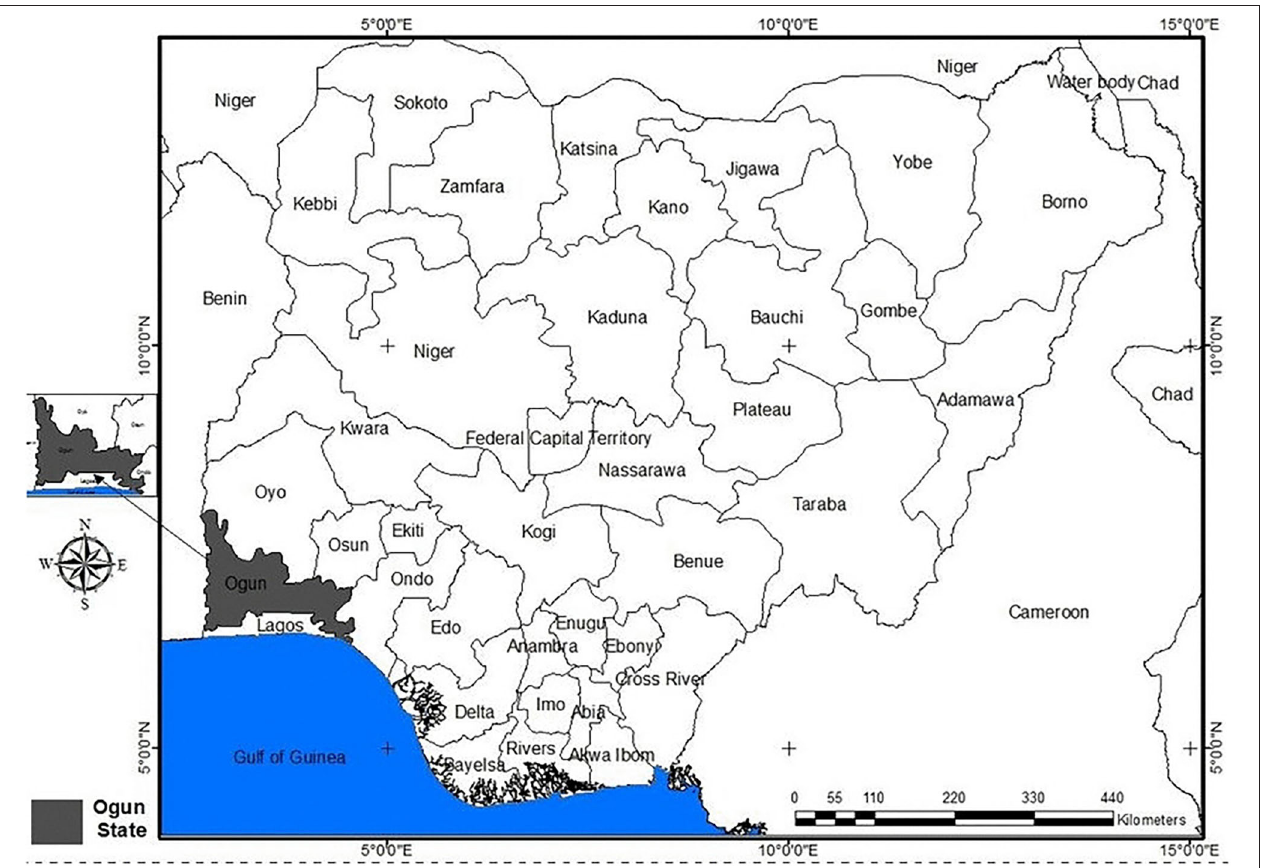
FIGURE 1 | Map of Nigeria showing the boundary of Ogun State, other States and neighboring countries (Source: Ogun State, Ministry of Land and Housing,